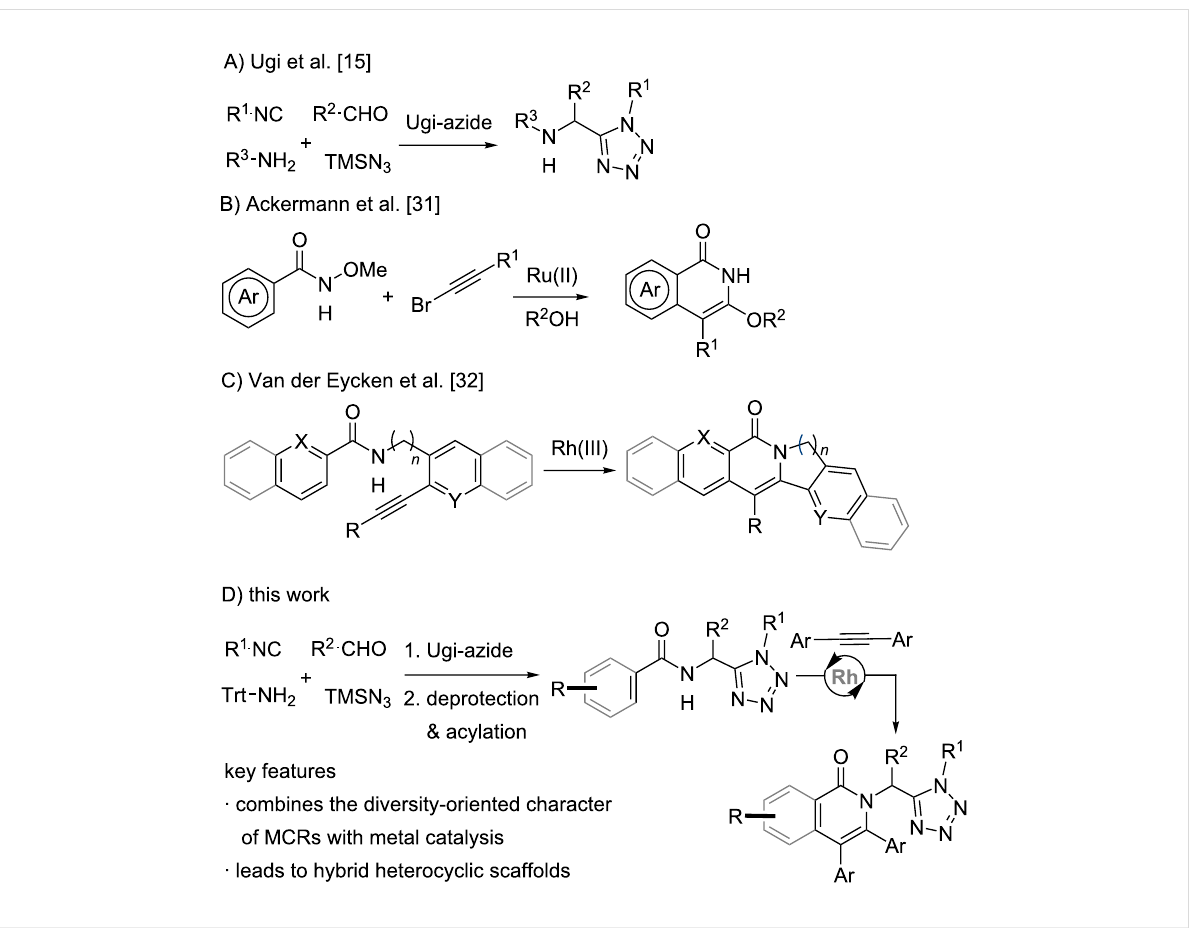
Scheme 1: Approaches for the synthesis of tetrazoles and isoquinolones and their interplay as designed in this work.